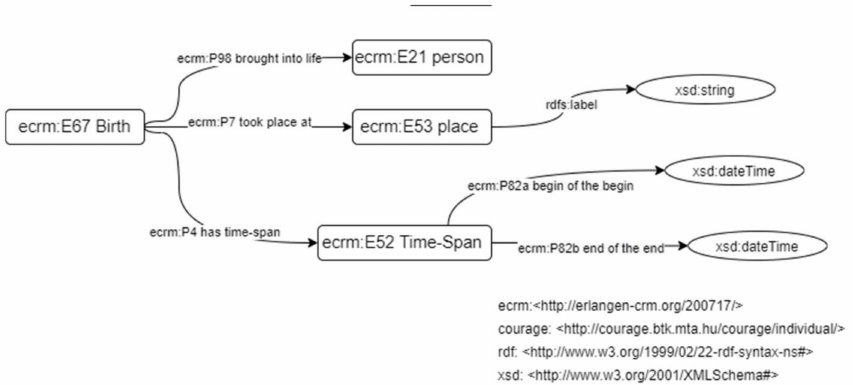
Figure 10. Birth event diagram in CIDOC-CRM ontology.